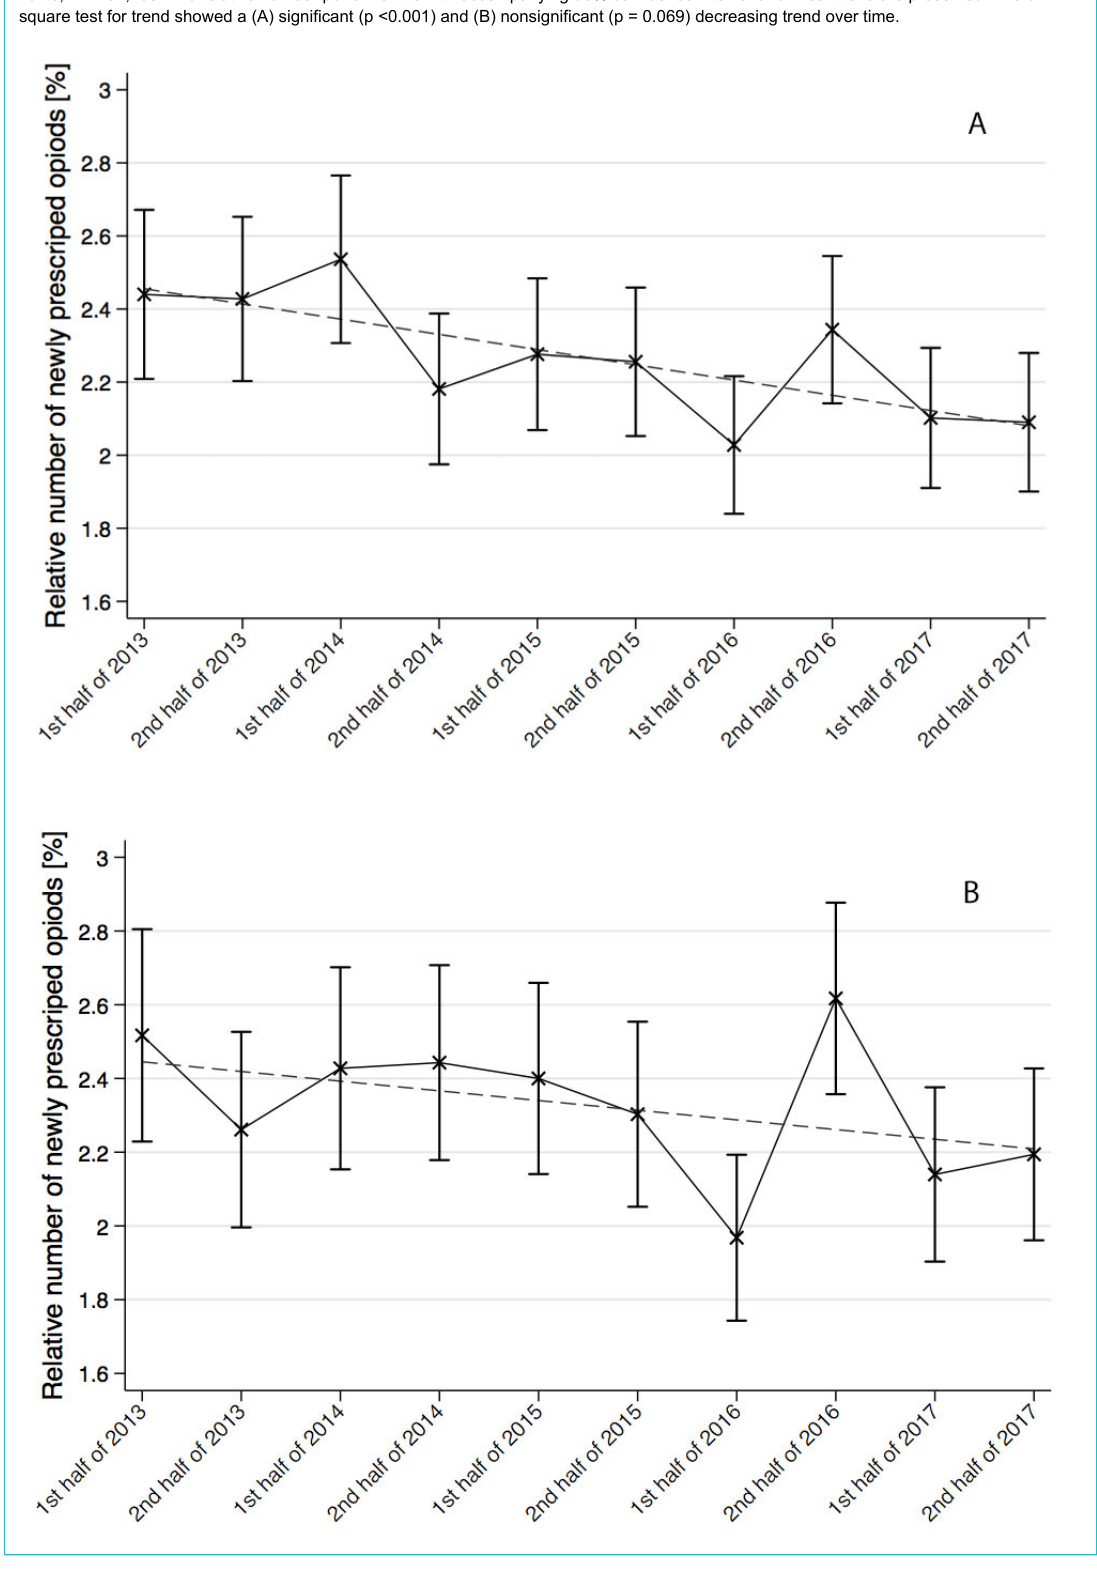
Figure S1: Incident opioid prescription, i.e., newly prescribed opioids in opioid-naïve patients (A) in all patients, n = 199,299; (B) in outpa- tients, n = 134,468. The relative number per 6 months with accompanying 95% confidence interval and linear trend are presented. The chi- square test for trend showed a (A) significant (p <0.001) and (B) nonsignificant (p = 0.069) decreasing trend over